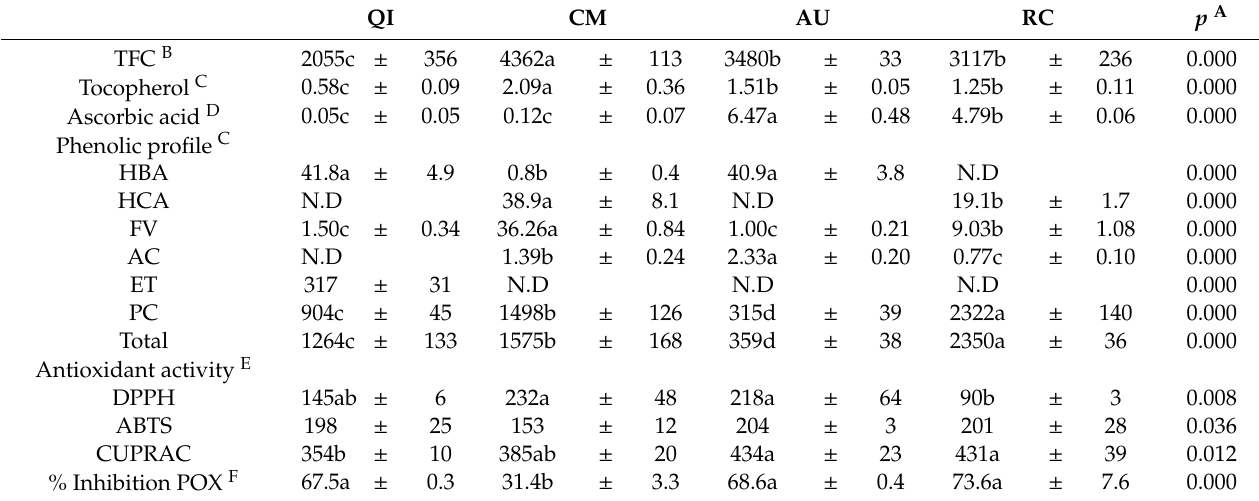
Table 1. Total phenolic content (TFC), tocopherol, vitamin C content and phenolic profile, and in vitro bioactivities of extracts from assorted fruits, namely, oaknut ( Quercus ilex subsp. ballota; QI), common hawthorn ( Crataegus monogyna Jacq.; CM), strawberry tree ( Arbutus unedo L., AU) and rose hips ( Rosa canina L.;